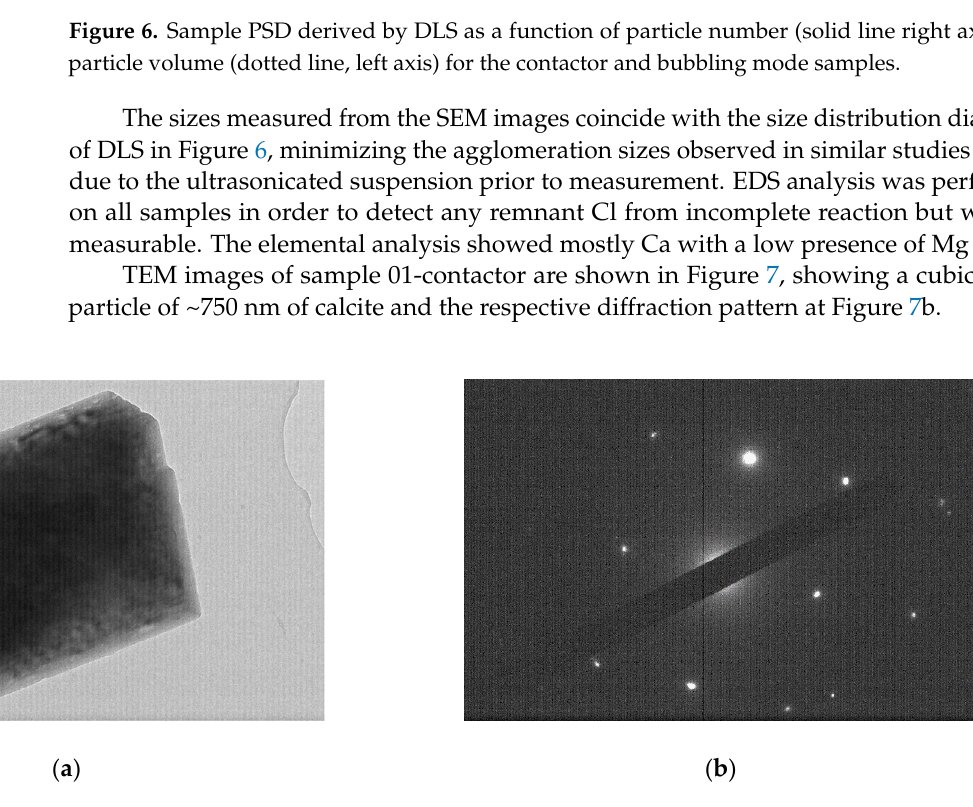
Figure 6. Sample PSD derived by DLS as a function of particle number (solid line right axis) and particle volume (dotted line, left axis) for the contactor and bubbling mode samples. Table 4. Number-based diameter parameters (Dn 10%, 50%, 90%) and volume-based diameter parameters (Dv 10%, 50%, 90%) of samples in contactor and bubbling mode. Distribution Analysis